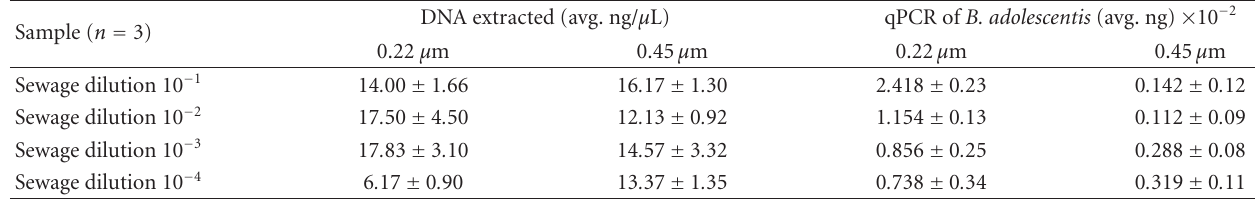
Table 2: DNA recovered and qPCR estimation of Bifidobacterium adolescentis in sewage sample DNA extracts from 0.22 μ m and 0.45 μ m of